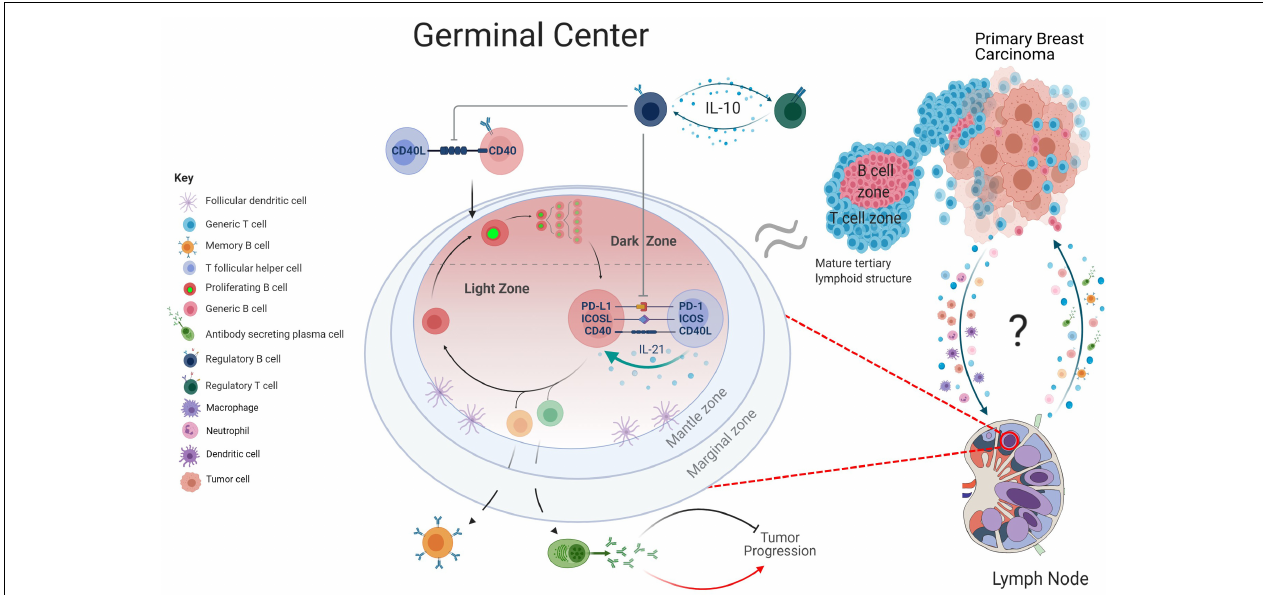
FIGURE 2 | Graphical depiction of GC regulation. Within the lymph nodes (LNs), B cells primed by T cells at the T/B border move into the GC and proliferate rapidly in the dark zone (DZ), before transitioning into the light zone. Here, engagement with T follicular helper cells through checkpoint inhibitor mechanism and cytokines such as IL-21 ensures affinity-based maturation of GC B cells. Upon upregulation of transcriptionally distinct profiles, the B cells differentiate into either a memory B cell, antibody secreting plasma cell or return to the DZ for additional proliferative rounds and hypermutation. Within the context of breast cancer, antibody production has been linked to both the inhibition and promotion of tumor progression. Regulatory B cell subsets can regulate this mechanism by suppressing Tfh mediated activation of B cells and promote an immune tolerant environment through secretion of IL-10. The transition of cancerous cells from the primary tumor to the lymphatics may be accompanied by a multitude of immune cell subsets, including antigen presenting cells. Further communication between LN and tumor and potential migration of B cell subsets, cytokines, and chemokines may be informative of how the GC responses can influence the tumor microenvironment. As the morphology of tertiary lymphoid structures is comparable to that of a B cell follicle, there may be mechanistic parallels that can be drawn between the two structures (created with